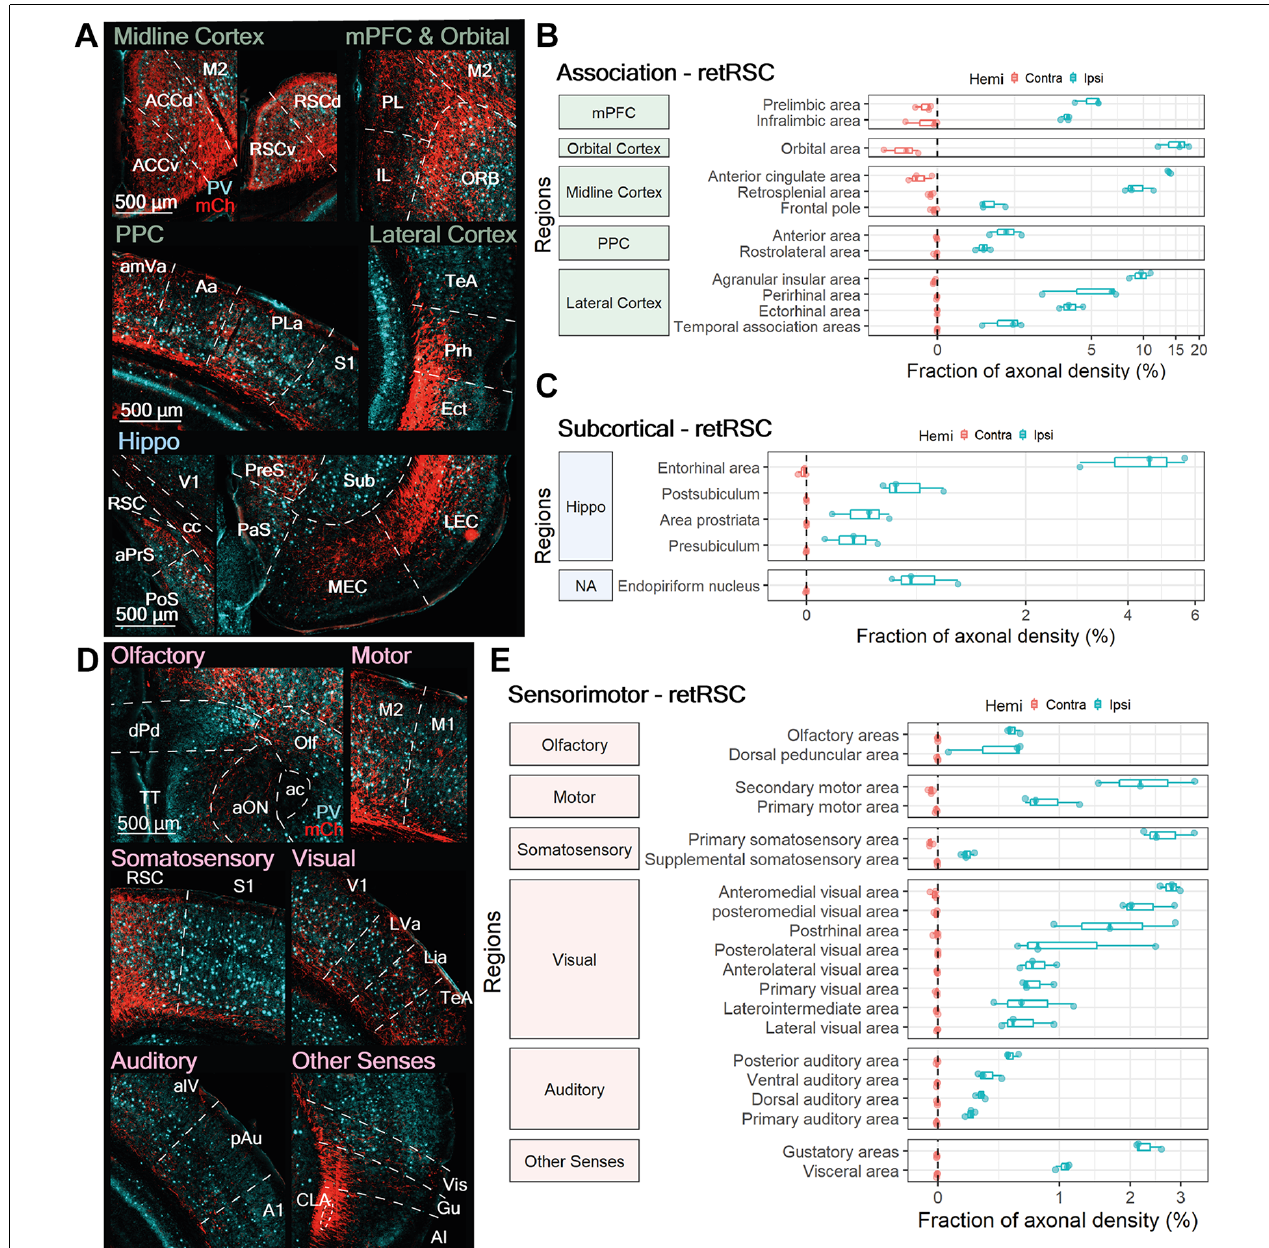
FIGURE 4 | RSC projecting neurons heavily innervate other association-related regions, some subcortical targets, and numerous sensorimotor regions. (A,D) Representative images from ipsilateral regions innervated by RSC-projecting CLA neurons (retRSC): (A) association, subcortical, and (D) sensorimotor. mCherry labeled axon fibers in red (mCh) and PV expression in cyan. (B,C,E) Quantification of regions innervated by retRSC in the contralateral (red) and ipsilateral (blue) hemispheres. Innervation from retRSC is largely ipsilateral, except for the orbital area. Axon fiber density from each region is represented as a fraction of whole brain axon density and is on a logarithmic scale. (B) retRSC preferentially innervates the orbital area, anterior cingulate cortex, and agranular insula over other cortical regions. (C) retRSC neurons also innervate several subcortical regions, with most related to the hippocampal formation. (E) retRSC neurons preferentially innervate secondary motor, primary somatosensory, secondary visual, and gustatory regions. Region abbreviations for (A) : ACCv, ACCd, Anterior cingulate cortex ventral, dorsal; M2, Secondary motor cortex; RSCv, RSCd, Retrosplenial cortex ventral, dorsal; IL, Infralimbic cortex; PL, Prelimbic cortex; ORB, Orbital area; amVa, Antereomedial visual area; Aa, Anterior area; PLa, Posterolateral visual area; S1, Primary somatosensory cortex; TeA, Temporal association cortex; Prh, Perirhinal cortex; Ect, Ectorhinal cortex; aPrs, Area prostriata; PoS, Postsubiculum; cc, Corpus callosum; V1, primary visual cortex; PaS, Parasubiculum; PreS, Presubiculum; MEC, LEC, Medial, Lateral entorhinal cortex; Sub, Subiculum. Region abbreviations for (D) : dPd, dorsal peduncular area; TT, Taenia tecta; aON, anterior olfactory nucleus; ac, anterior commissure; Olf, Olfactory areas; M2, Secondary motor cortex; M1, Primary motor cortex; RSC, Retrosplenial cortex; S1, Primary somatosensory cortex; V1, Primary visual cortex; LVa, Lateral visual area; Lia, Laterointermediate area; TeA, Temporal association area; alV, anterolateral visual area; pAu, posterior auditory area; A1, Primary auditory area; CLA, Claustrum; Vis, Visceral area; Gu, Gustatory area; AI, Agranular Insula.